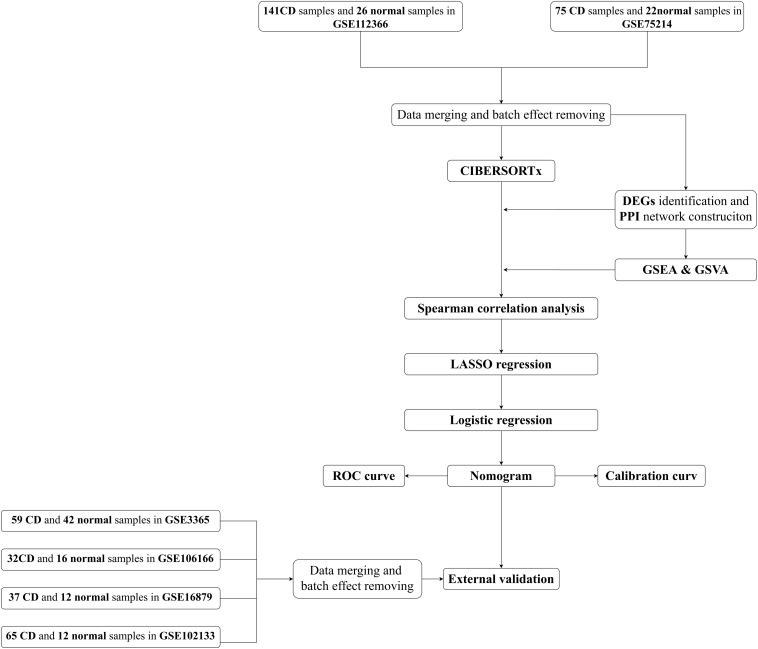
Flow chart of the analyses used in this study.